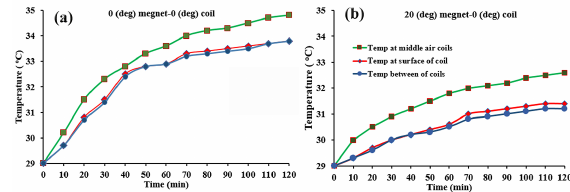
Fig. 5. Comparison of temperature at; (a) 0 (deg) magnet-0 (deg) coil and (b) 20 (deg) magnet-0 (deg) coil, when the PMSG generator was operated at wind speed 8 m/s, 120 rpm.